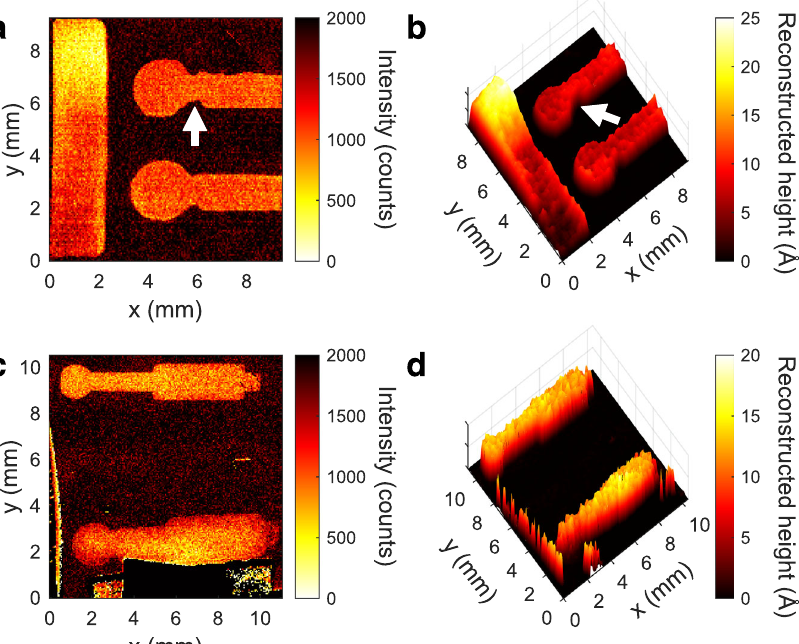
Fig. 4 | SHeM micrographs and associated reconstructed height maps for gold contacts evaporated onto silicon wafer substrates. a SHeM micrograph of gold thickness calibration bar with laterally defective (upper) and ideal (lower) gold contacts. b Corresponding reconstructed height map from a . c SHeM micrograph